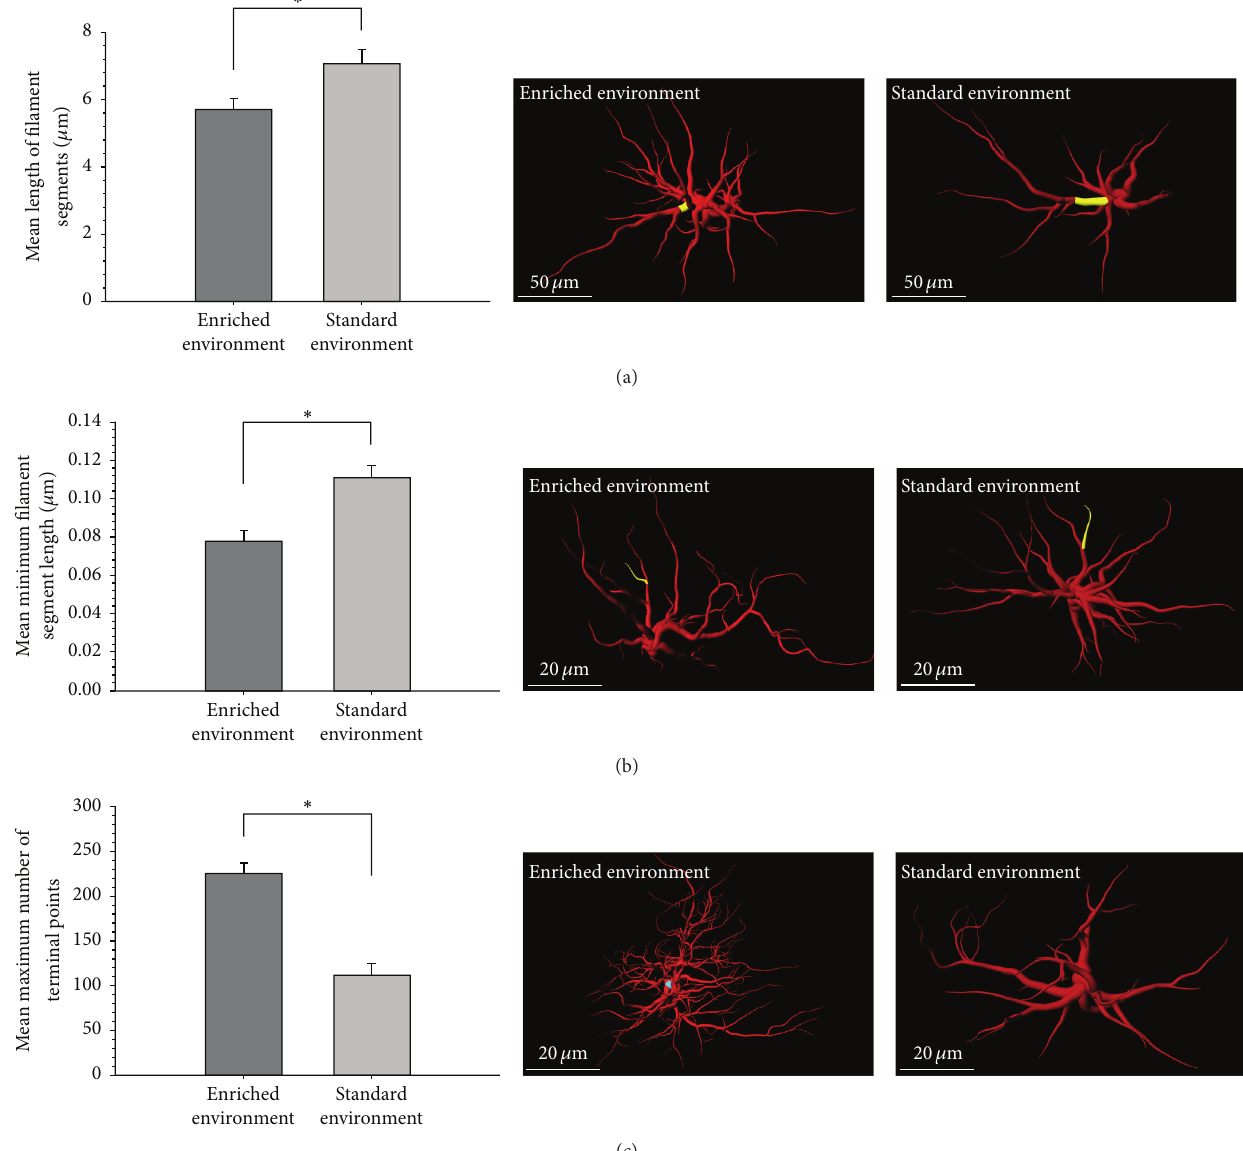
Figure3:(a)Meanlengthoffilamentsegments(regionsbetweenbranchpoints),(b)meanminimumfilamentlength,and(c)meanmaximum number of terminal points. ∗ denotes a 𝑝 value of <